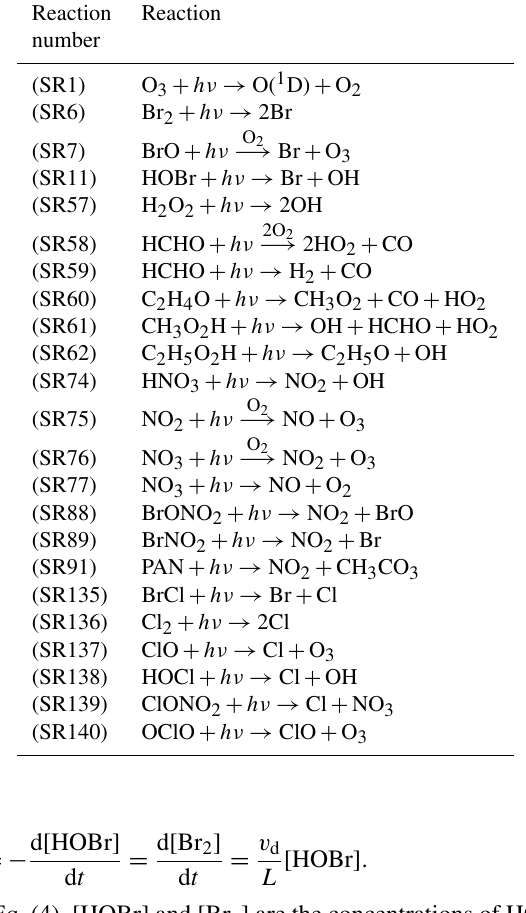
Table 1. List of photolysis reactions in the chemical mechanism of the KINAL model, the rates of which vary with TOC. The reaction numbers correspond to those listed in Table S3 in the